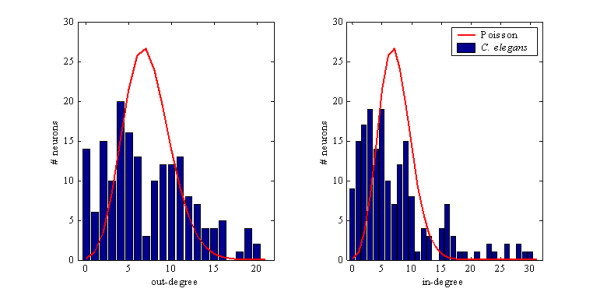
Distribution of degree in C. elegans in comparison to Poisson distribution. The distribution of in-degree and out-degree in a random matrix (Erdõs-Rényi random graph) can be approximated by Poisson. We observe that the distribution in C. elegans is significantly different from Poisson (p < 7%). Figure shows in-degree and out-degree for dataset 1, Θ = 1; Dataset 2 and other thresholds give similar results.